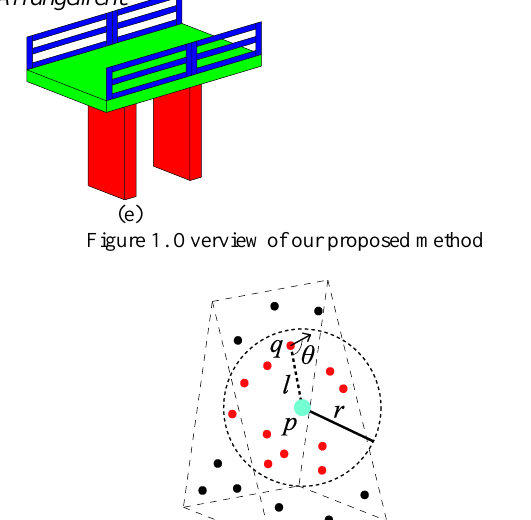
Figure 2. Graphical description of shape context